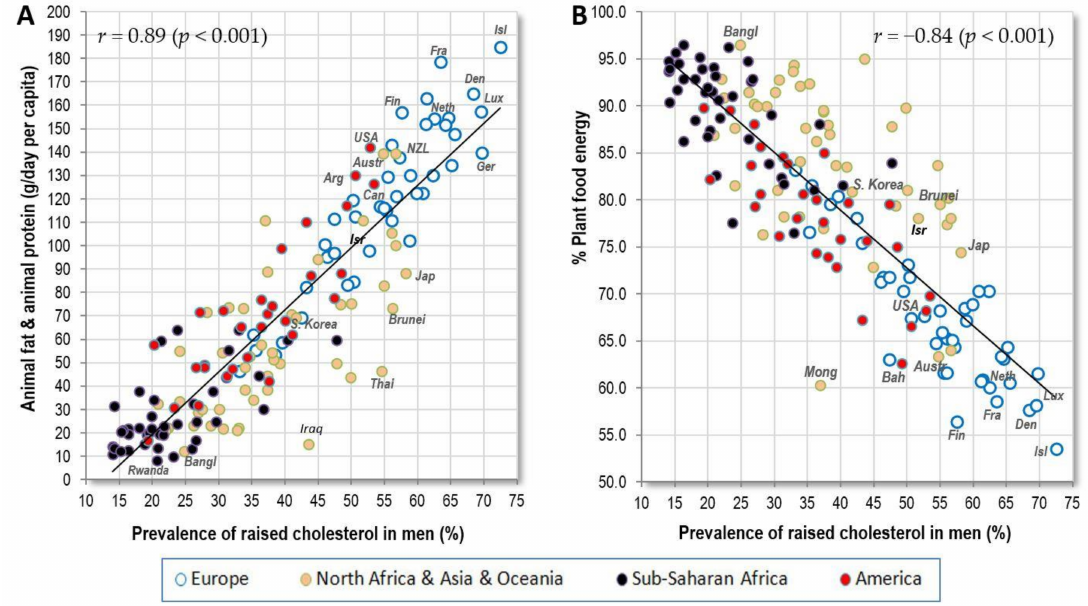
Figure 5. ( A ) Relationship between the prevalence of men’s raised cholesterol (%; WHO, 2010) and the mean consumption of animal fat and animal protein (g/day per capita; FAOSTAT, 1993–2011); ( B ) Relationship between the prevalence of men’s raised cholesterol (%; WHO, 2010) and the mean proportion of plant food energy in the diet (FAOSTAT, 1993–2011).